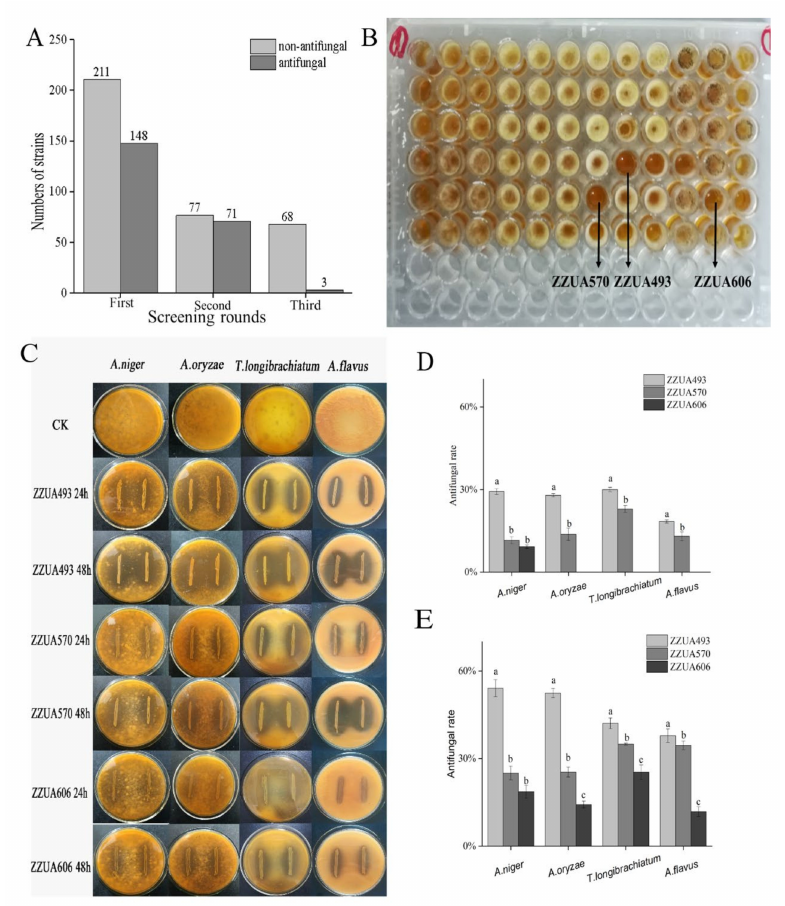
Figure 2. Detection of antifungal ability by 96-well microtiter plate and dual-culture overlay assay method. The strains with antifungal ability against A. niger screened out in three rounds by 96-well microtiter plate method ( A ); 96-well plate method was used to detect the antibacterial activity of 71